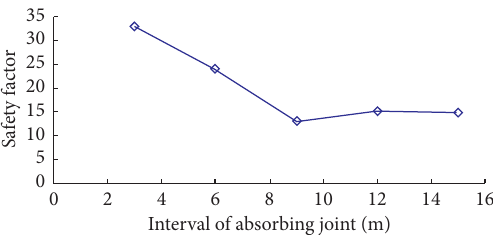
Figure 15: Relationship between safety factor of vault and interval of absorbing